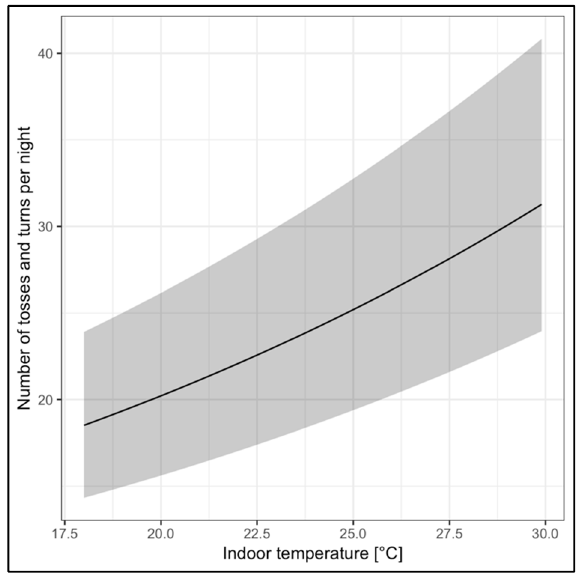
Figure 3. Relationship between indoor temperatures and number of tosses and turns during sleep periods. The gray shading represents the 95% confidence interval.